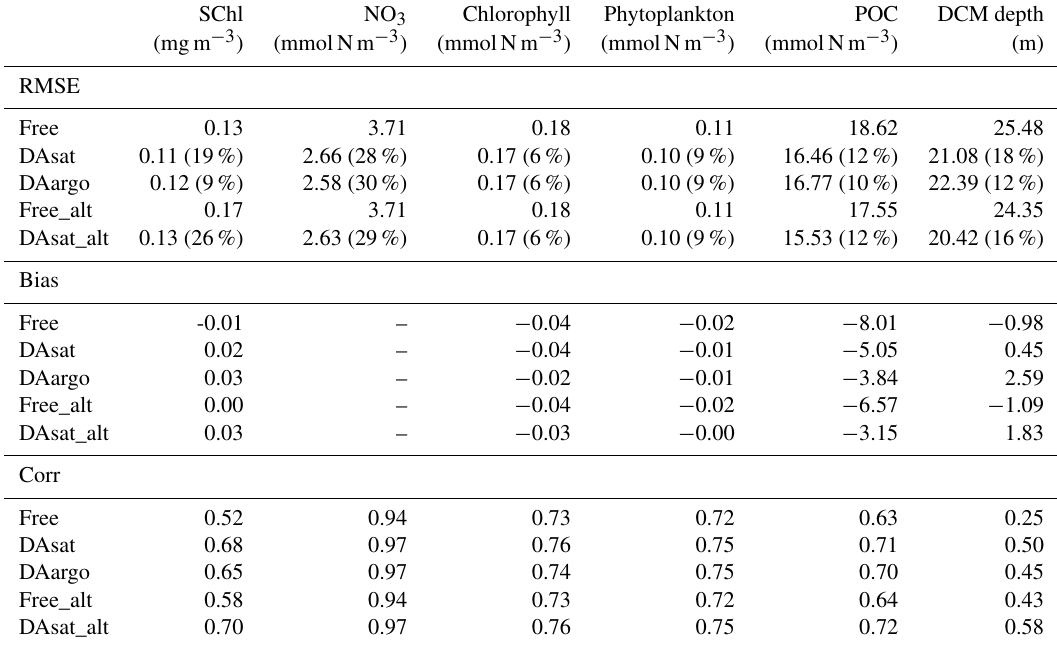
Table 2. The root mean square error (RMSE), bias, and correlation coefficient (Corr) for surface chlorophyll in the open gulf, along with vertical profiles of NO 3 , chlorophyll, phytoplankton, and POC, as well as the depth of the deep chlorophyll maximum with respect to observations from BOEM floats. Percentages in the parentheses represent the relative reductions in RMSE values. Only a reduction in RMSE larger than or equal to 10% is considered a significant improvement. The NO 3 is estimated based on its climatological relationship with temperature. Since the estimated NO 3 tends to be overestimated in warm regions, the unbiased RMSE of NO 3 is reported and the bias is not shown